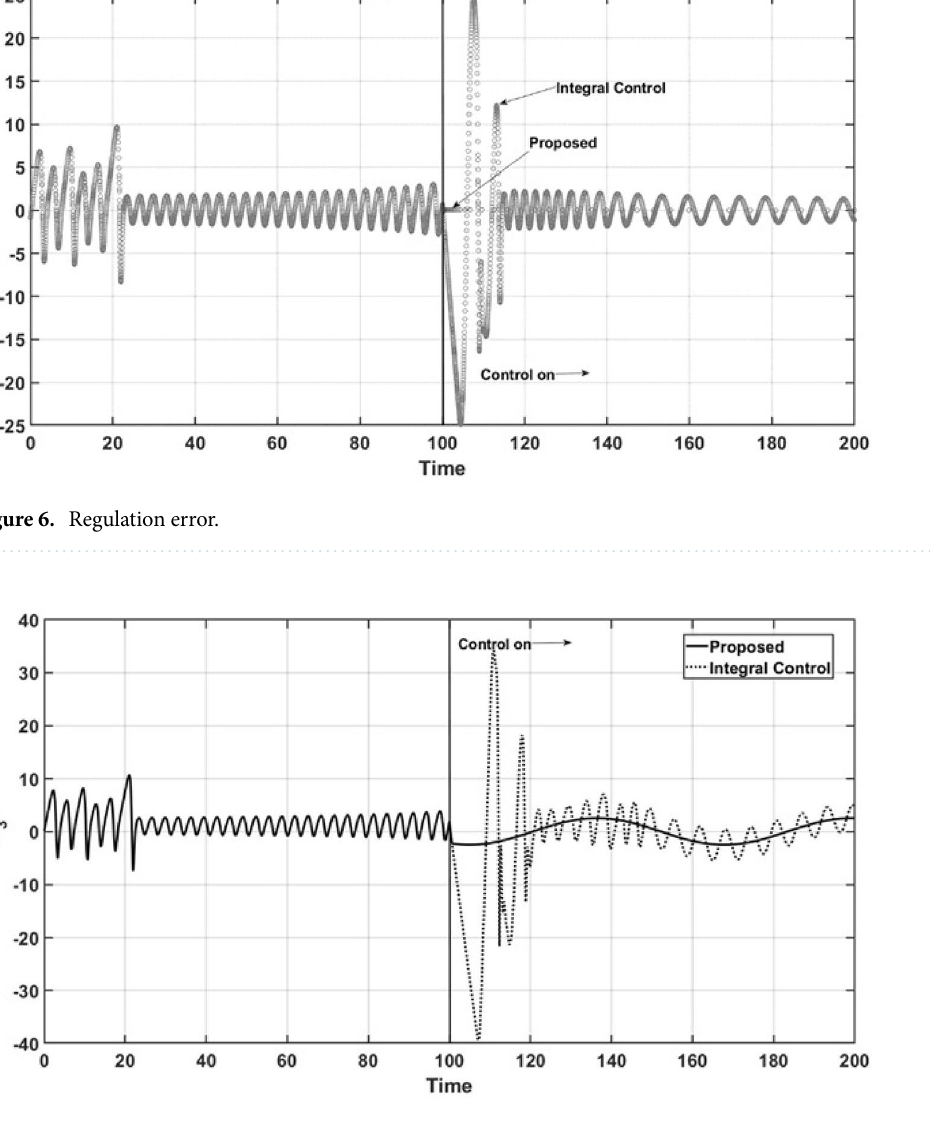
Figure 7. Tracking